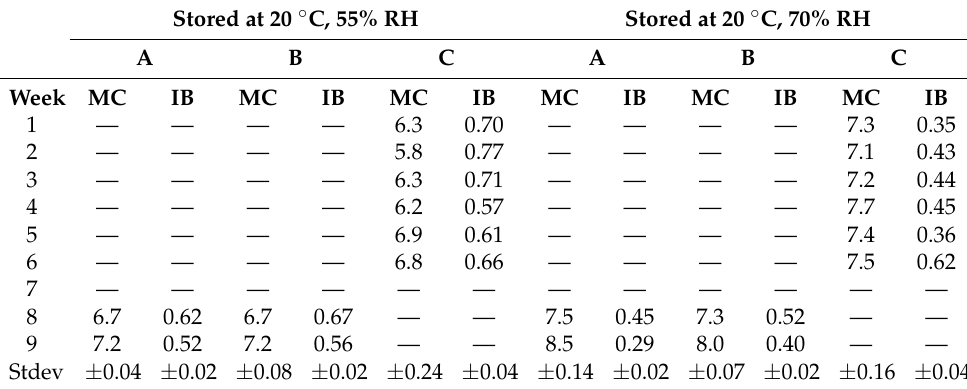
Table 3. Results for MDF boards stored in climatic